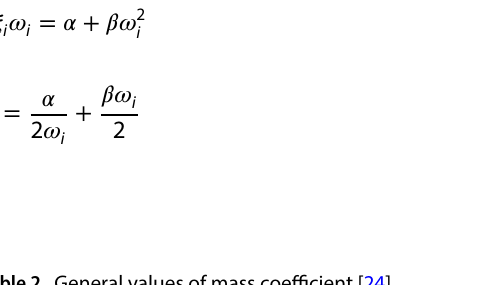
Table 2 General values of mass coefficient [24] General value